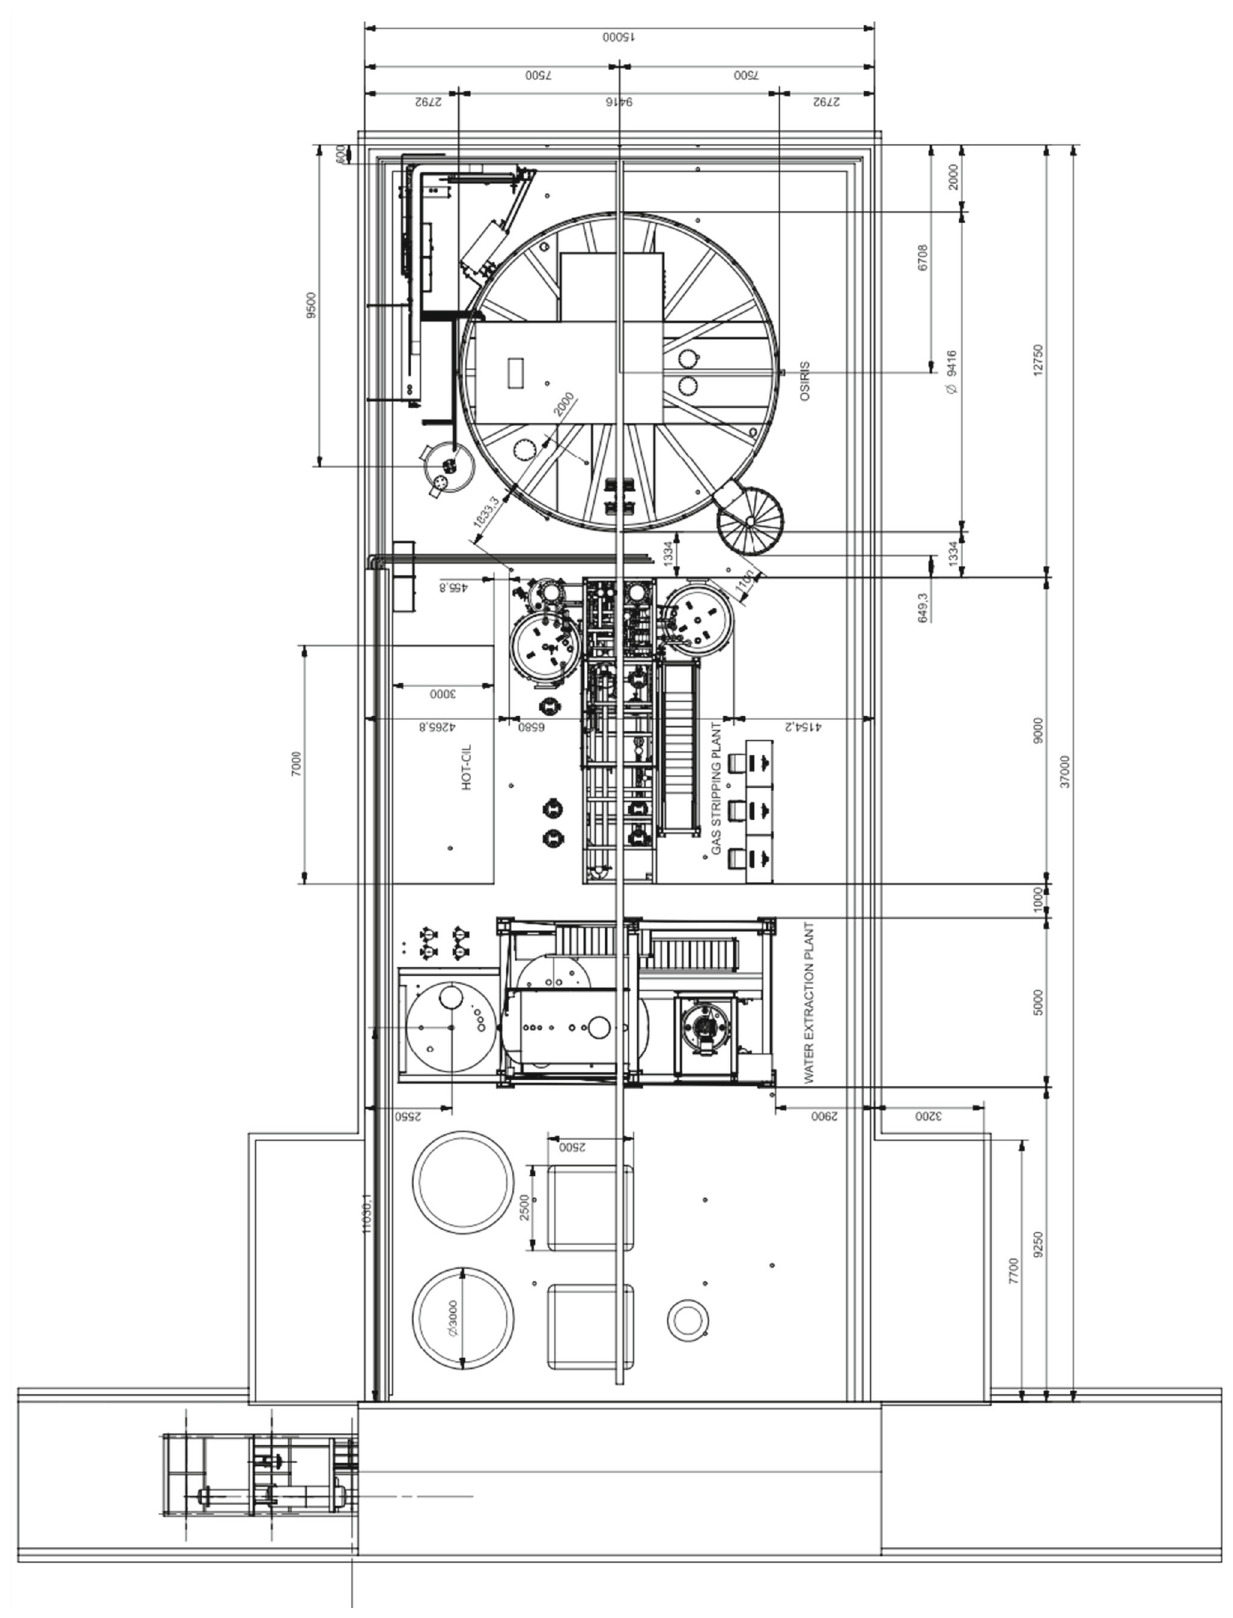
Fig. 22 Layout of the underground Liquid Scintillator Hall. OSIRIS is located at the back of the hall, next to the Stripping